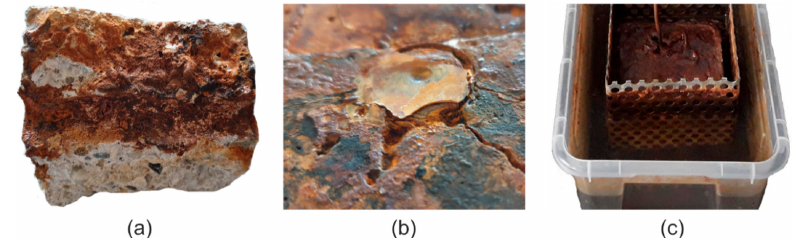
Figure 6. Accumulation of corrosion products of the rebar steel during experimental tests: ( a ) sample break in the fracture, ( b ) detachment of resin from the bar face, ( c ) contaminated water and container with corrosion products.